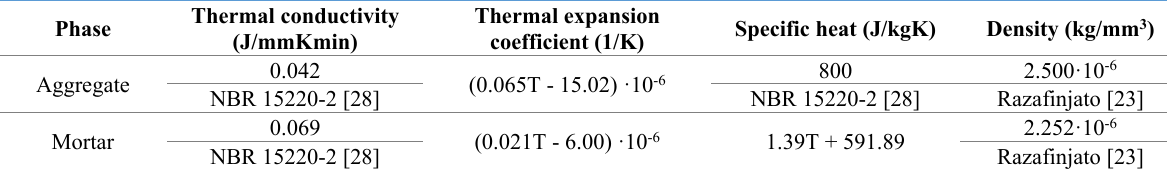
Table 2. Materials thermal properties, T being the temperature considered.